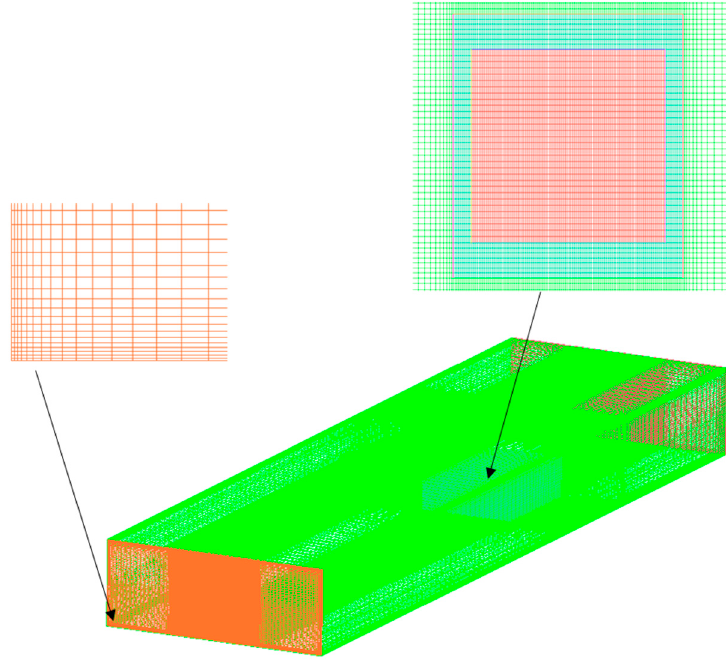
Figure 2. Grid model.